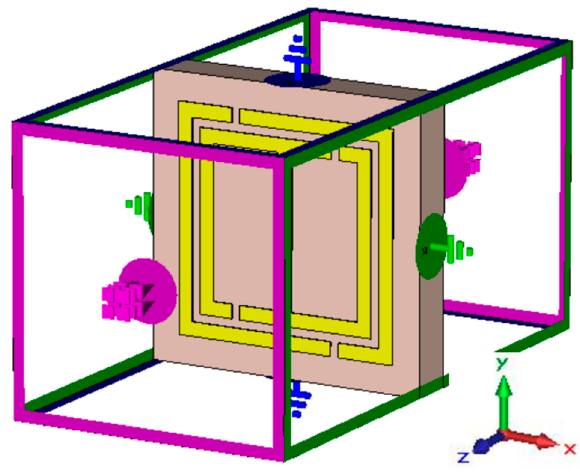
Figure 4. Simulation setup with boundary condition in CST-MWS.